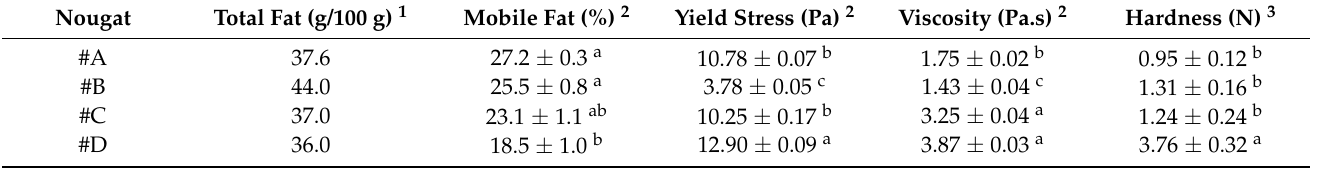
Table 2. Fat distribution and physical properties of base nougat. Mean values with different superscripts in a column indicate statistical differences ( p < 0.05).